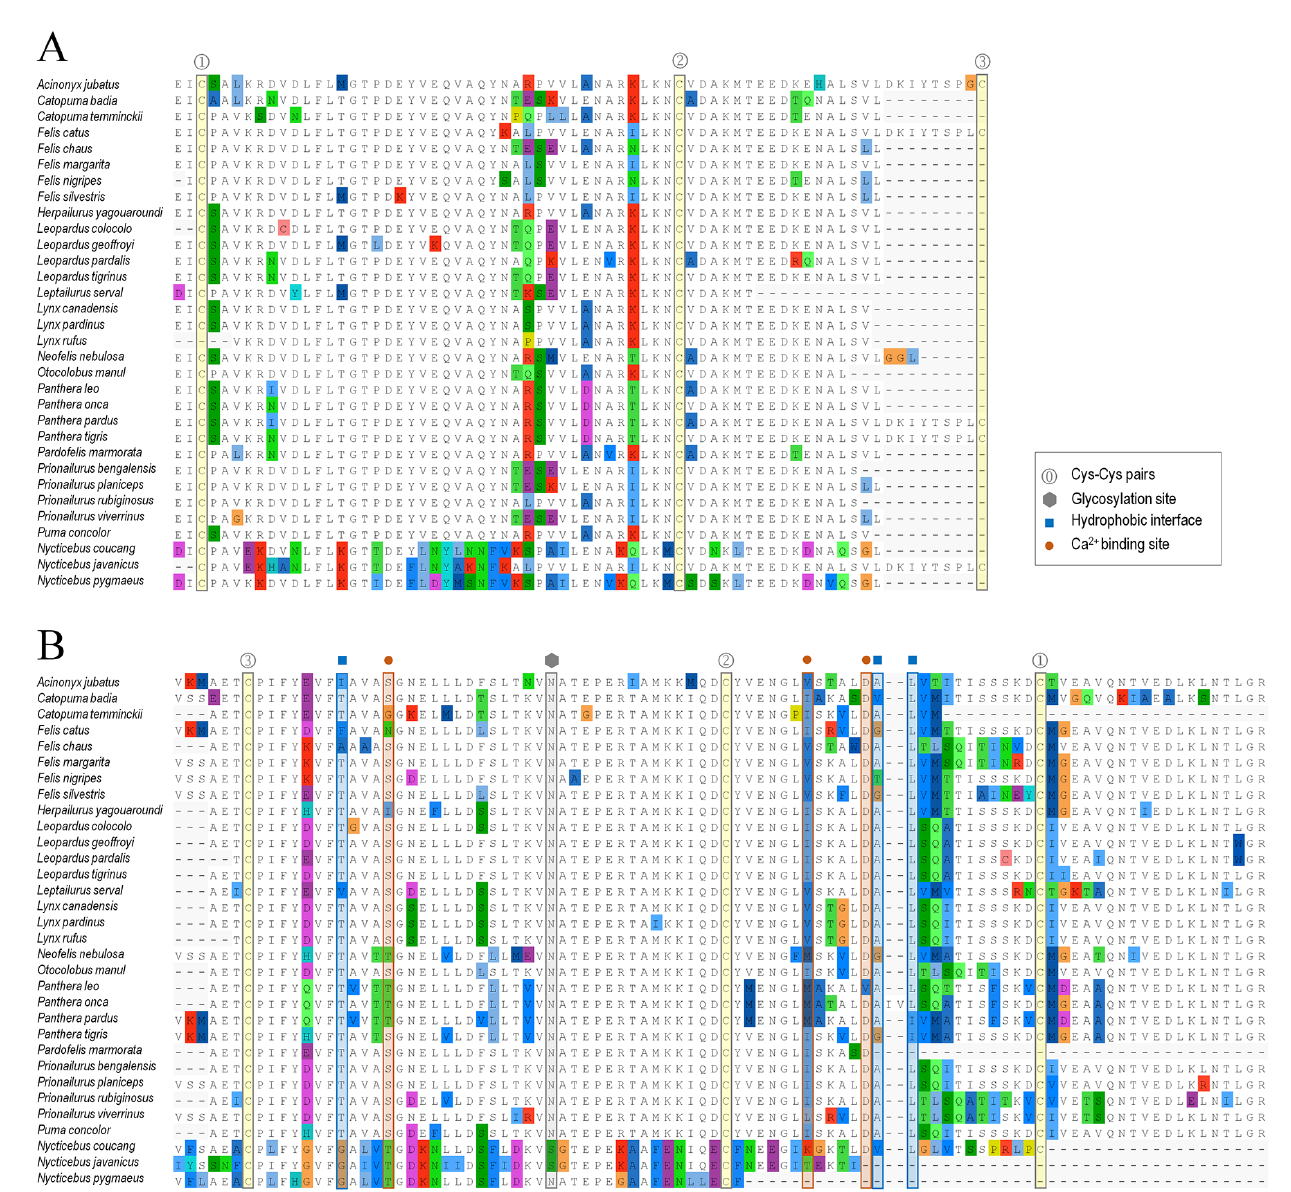
Figure 1. Sequence alignment for felid Fel d 1 and loris BGE protein. (A) Chain 1, (B) chain 2. Characters are colored highlighting differences from majority rule consensus. Structurally relevant positions are highlighted according to the legend box and include Cys-Cys pairs, interface hydrophobic residues, Ca 2+ binding residues and a glycosylation